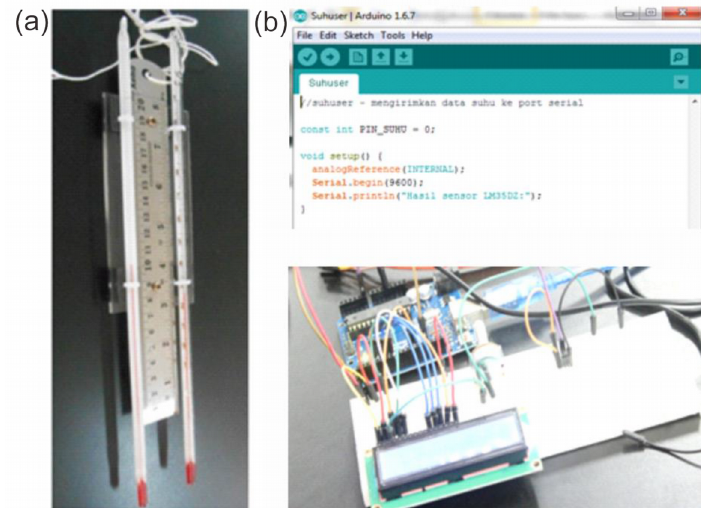
Figure 9. Fourth Equipment design to exercise problem-solving laboratory activities on making (a) an analog and (b) a digital thermometer. A model of Fahrenheit or Reaumur thermometer can be